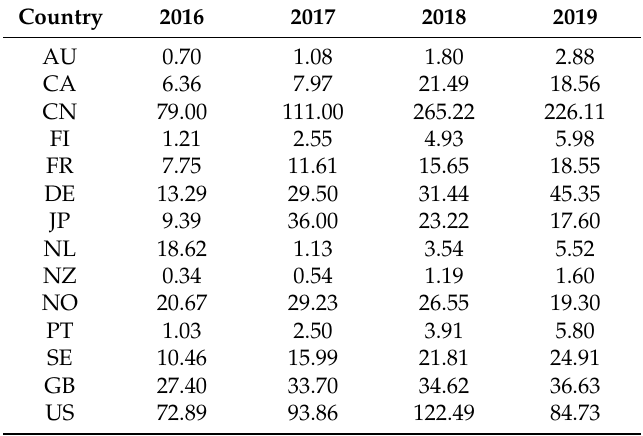
Table 4. Actual values of plug-in hybrid electric car sales (PHECS).